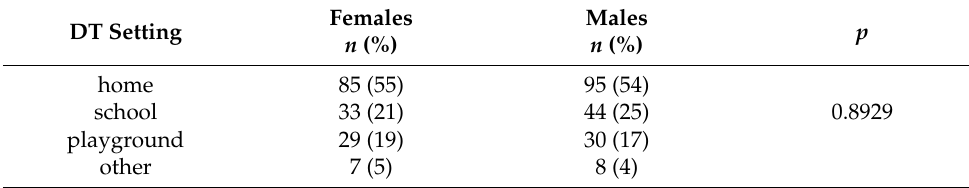
Table 2. Distribution of DT regarding the